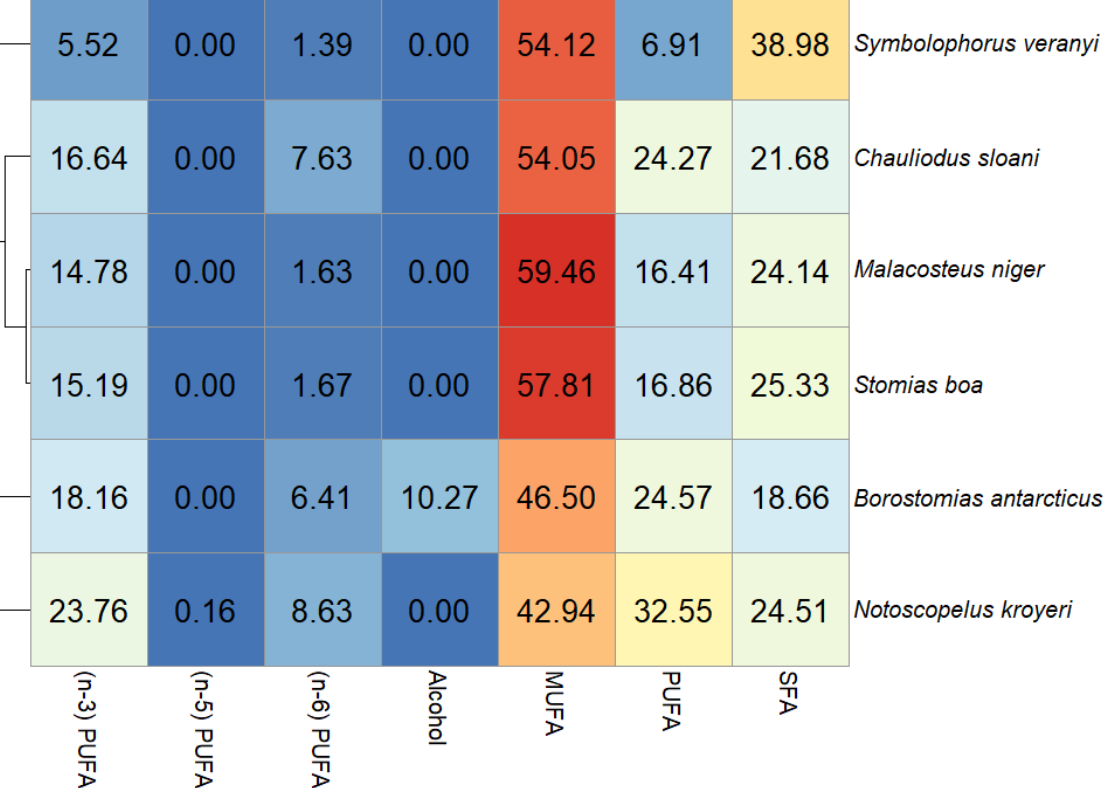
Figure 2. Heat map of total fatty acid/alcohol content (% of total FAs) in muscle tissues of mesopelagic fishes ( Notoscopelus kroyeri , Symbolophorus veranyi , Chauliodus sloani , Stomias boa , Malacosteus niger , and Borostomias antarcticus ) inhabiting the 250 – 700-m depth gradient in the Irminger Sea (North Atlantic).